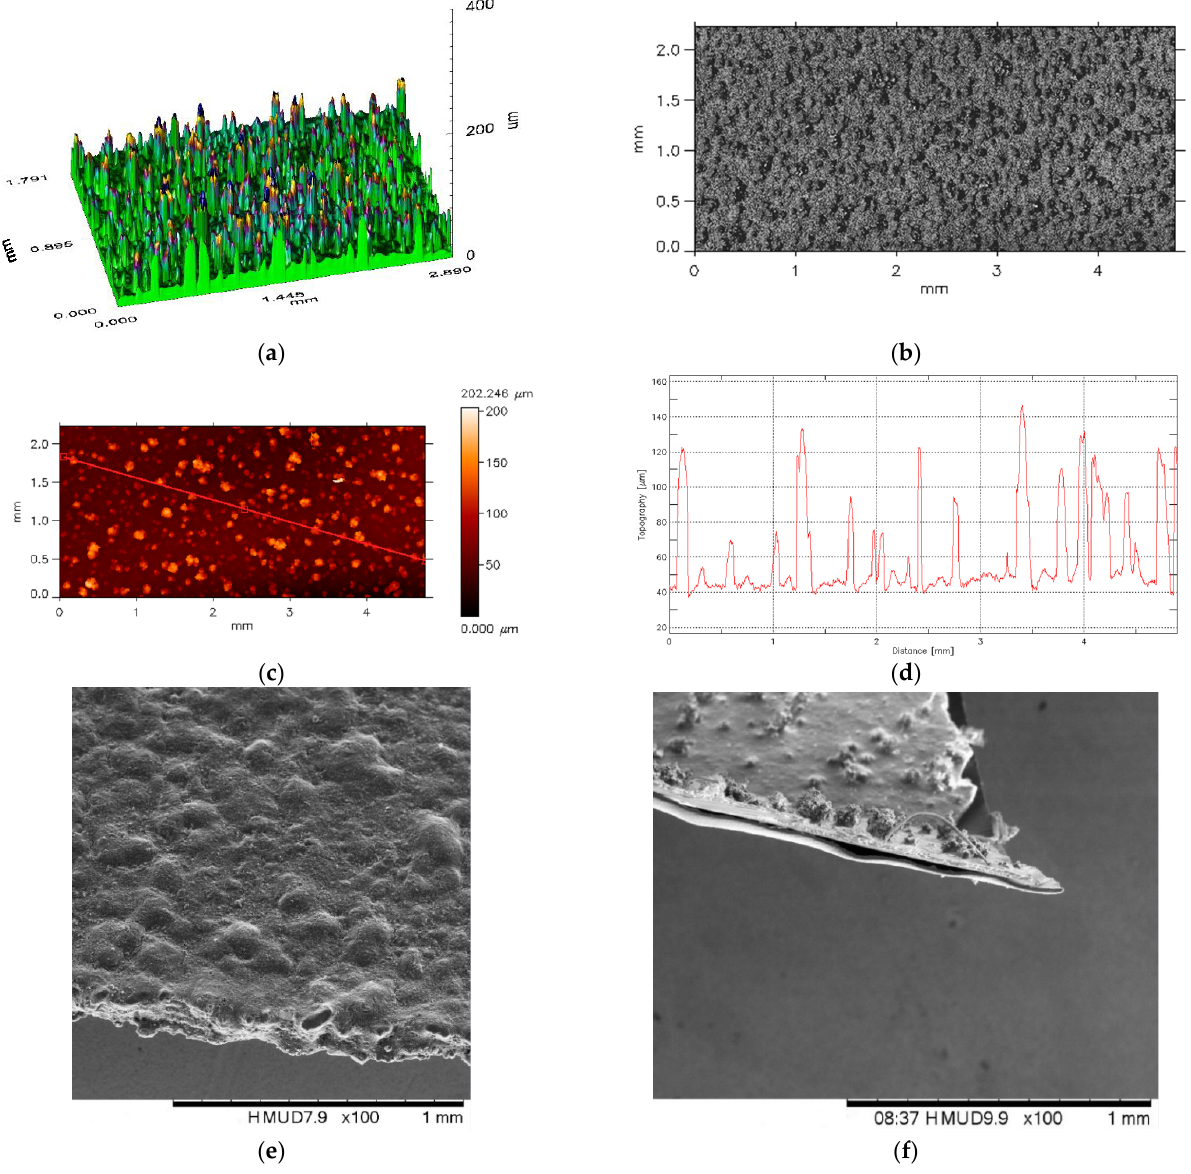
Figure 1. Results of the TSP coating surface morphology investigation: ( a , b ) three-dimensional sur- face image, ( c ) typical profile (red line cross-section), ( d ) diagram of a normalized dimensional spec- tral analysis result, ( e , f ) SEM images of TSP layer fragment separation for microscopic structure inspection.